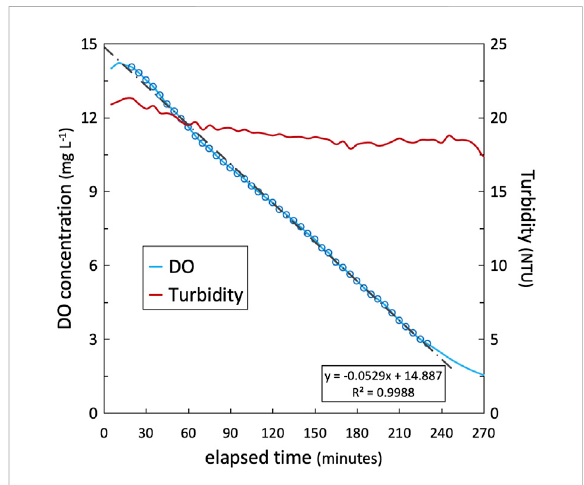
FIGURE 3 Example of oxygen depletion curve for a chamber placed at site CA2 (July 2021). The turbidity trend is superimposed. Slope m is calculated for the approximately straight section of the oxygen- depletion curve, which is highlighted with light blue